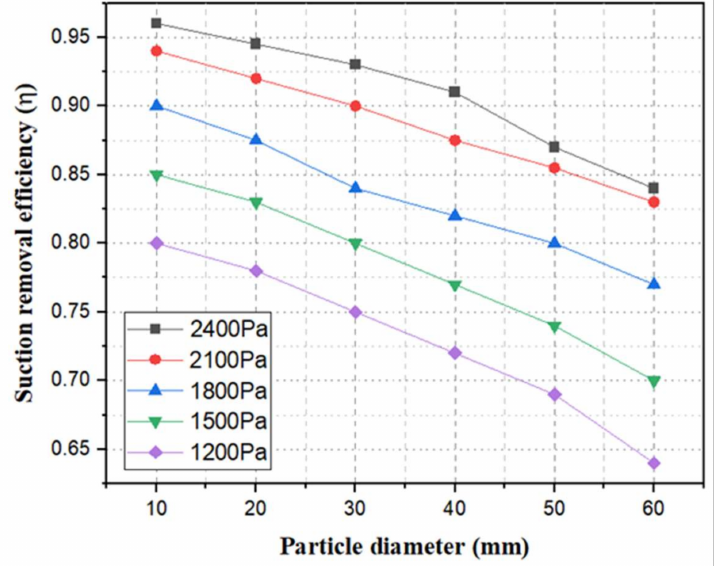
Figure 13. Experimental result effects of different particle diameters on suction efficiency.